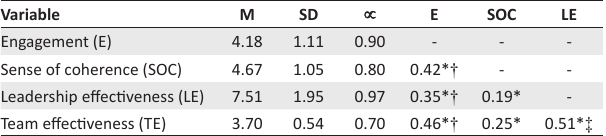
TABLE 2: Means, standard deviations, internal consistency reliabilities, and inter- correlations of study variables. Variable